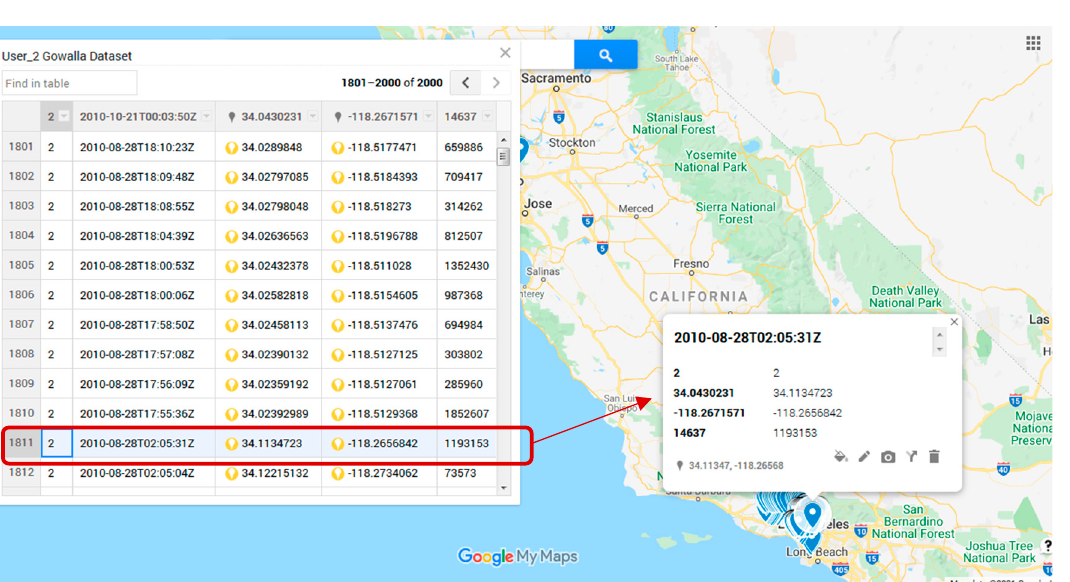
Figure 1. Features of the 1811th check-in of the user with ID 2 in the Gowalla dataset.